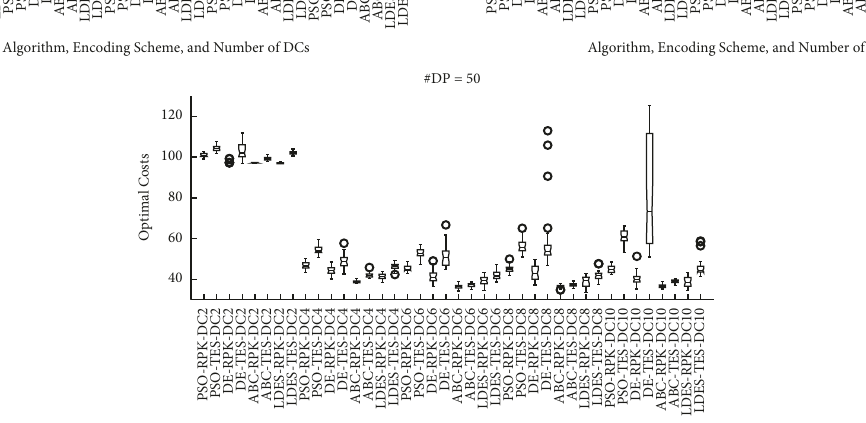
Algorithm, Encoding Scheme, and Number of